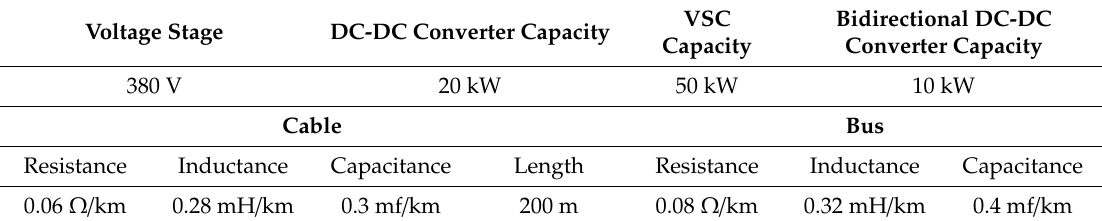
Table 1. The main parameters of simulation system.